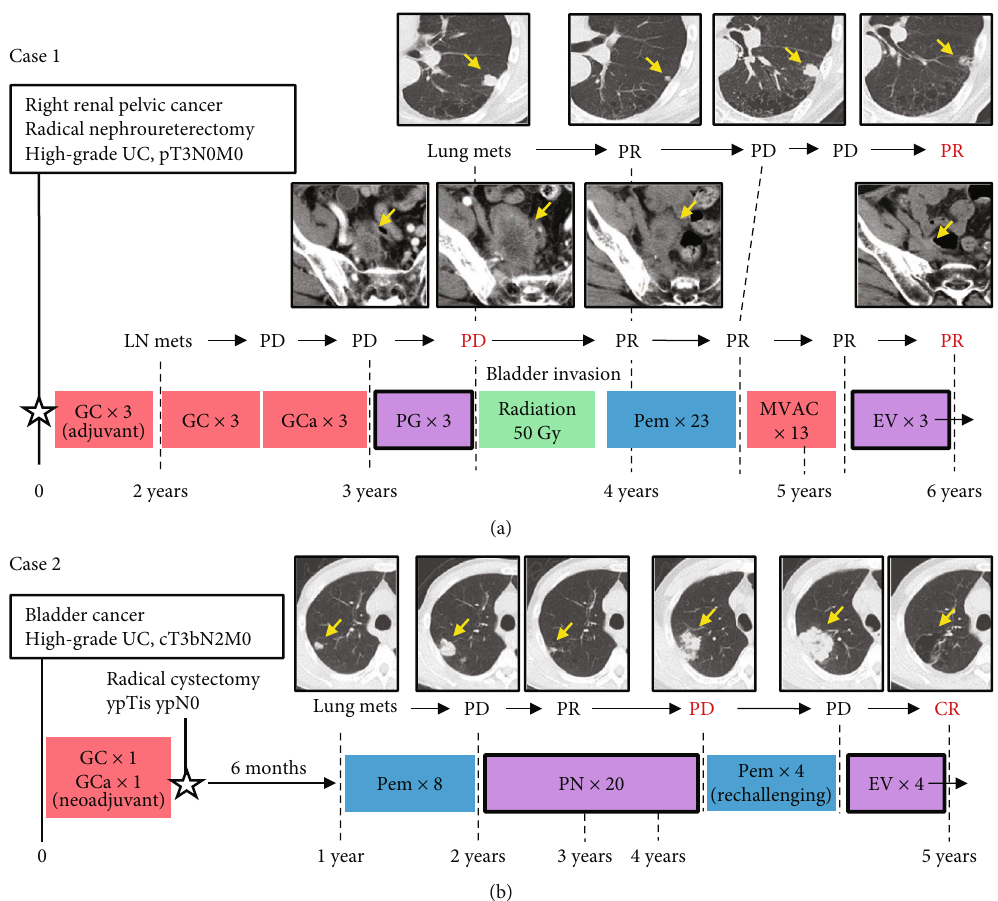
Figure 2: Clinical courses of two cases who treated with taxane-based chemotherapy and enfortumab vedotin. The details of the clinical course are described in the main text. Both patients are alive, and EV treatment is ongoing. Yellow arrows indicate metastatic